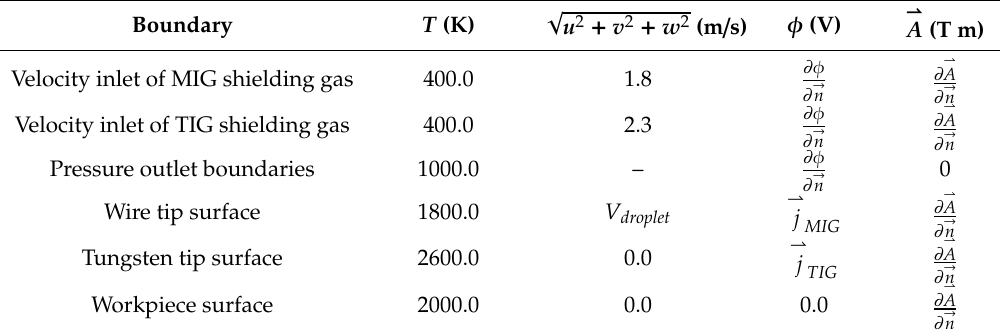
Table 1. Boundary